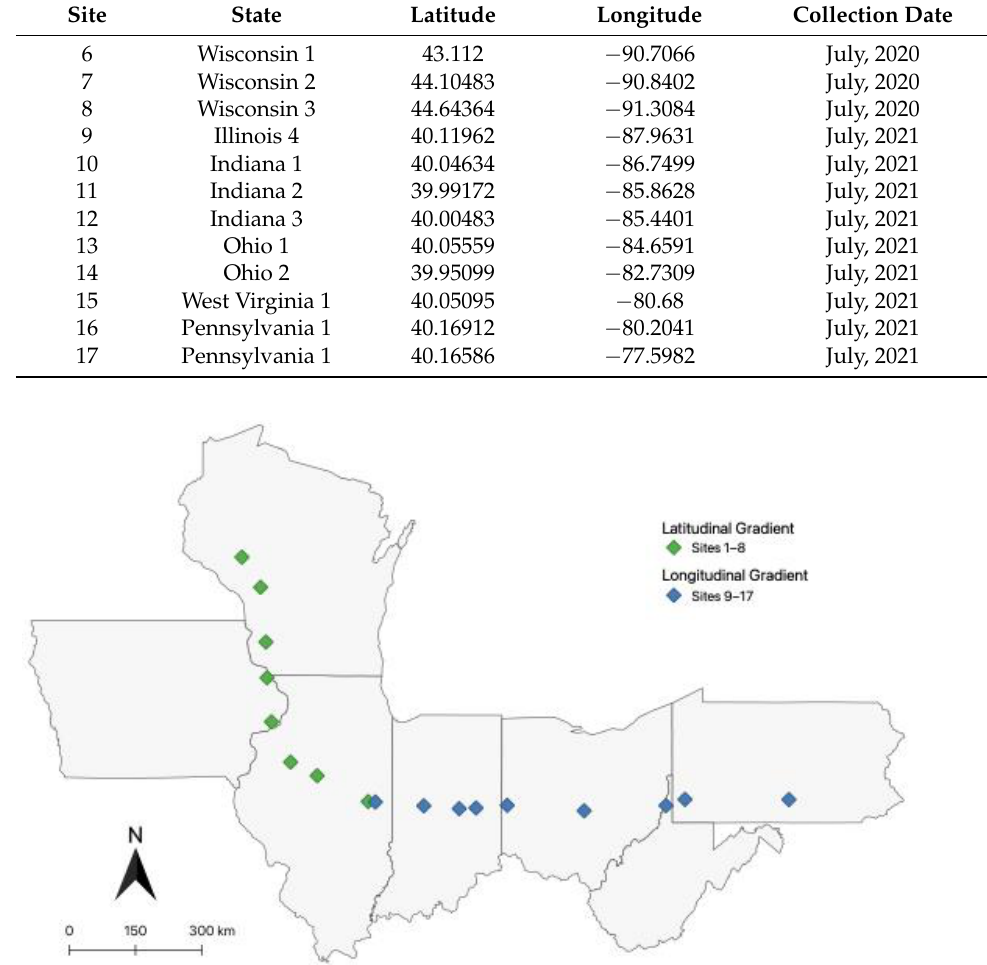
Figure 1. Map depicting the sampling sites of both collection trips. The latitudinal gradient (green) comprises 8 sites from Urbana, IL to Eau Claire, WI (~680 km). The longitudinal gradient (blue) comprises 9 sites from Urbana, IL to Newburg, PA (~1078 km). Table 1. Sampling locations and GPS information for Depressaria depressana collected from wild car- rot ( Daucus carota ) for this study.